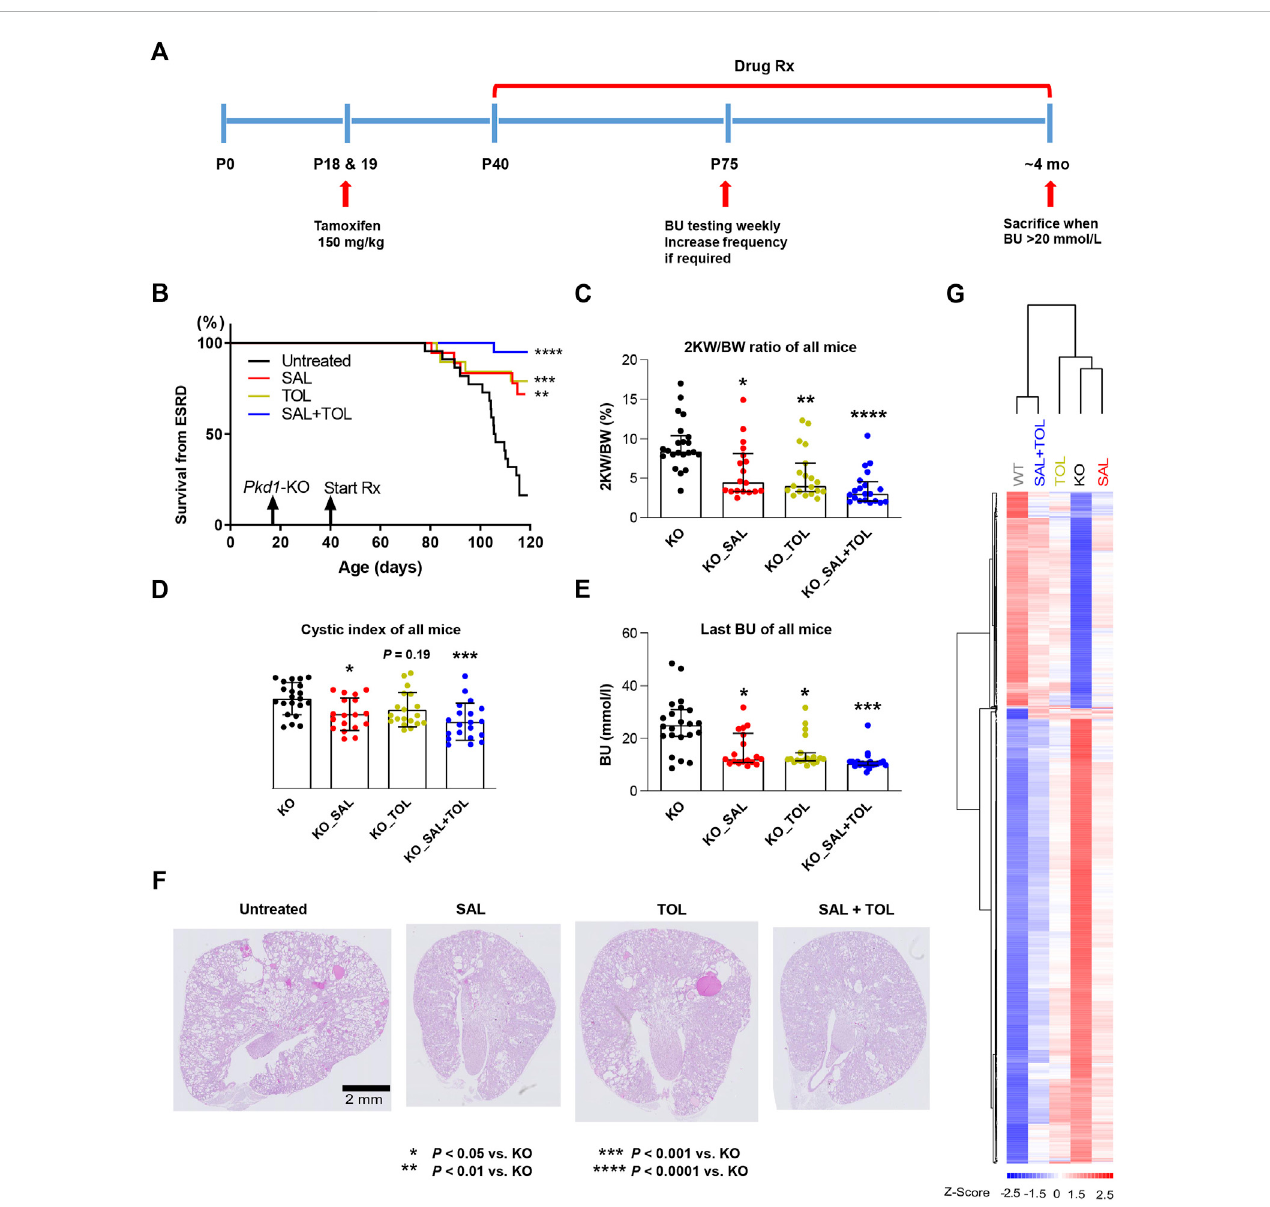
FIGURE 1 Combinedtreatmentimprovedkidneysurvivalandcysticparameters. (A) Experimentalprotocol.Wetestedtheef fi cacyofsalsalate(SAL),tolvaptan(TOL) or combination (SAL + TOL) in a tamoxifen-inducible Pkd1 conditional KO mouse model (iKsp- Pkd1 del mice). Male mice were treated with tamoxifen at days P18 and P19 to inactivate Pkd1 gene and drug treatment began on day P40. Untreated mutant mice began to develop advanced kidney failure at around ~ P105.BUmonitoring via tail-veinbloodsamplingbeganatP75toidentifythosemicewithkidneyfailure;allmicewithaBU > 20 mmol/Lwereconsidered to have ESRD andsacri fi ced. When~75% of theuntreated mutant micereachedESRD, all themice fromall study groups weresacri fi ced. (B) Kidneysurvival of untreated versus treated mice. (C) 2 KW/BW%, (D) cystic indices, and (E) BU of all mice at their respective endpoints. (F) Representative PAS-stained kidney sections(i.e.,themedian)fromdifferentstudygroups.All Pkd1 mutantmicewithandwithoutESRDwereincludedin (B – E) ;untreatedKO(n=22),SAL(n=18), TOL (n = 19), SAL + TOL (n = 20). (G) Hierarchical clustering using top 1,000 differentially expressed genes between KO (n = 12) and WT (n = 10) kidneys showing the SAL (n = 11), TOL (n = 12), and SAL + TOL (n = 12) treatments attenuated gene expression changes in Pkd1 mutant kidneys, but co-treatment showedoveralllargerfoldchangesthanthemonotherapies. Therowandcolumndendrogramsdisplaythedistanceorsimilaritybetweengenesandsamples, respectively. Columnsrepresent fi vegroups(WT,KO,KO_SAL,KO_TOL,andKO_SAL+TOL)androwsrepresenttheZ-scorescaledaveragegeneexpression levels of each group. White is the mean expression across all groups (set to 0), red indicates greater than the mean and blue, less than the mean. Z-scores are computed on a gene-by-gene basis by subtracting the mean and then dividing by the standard